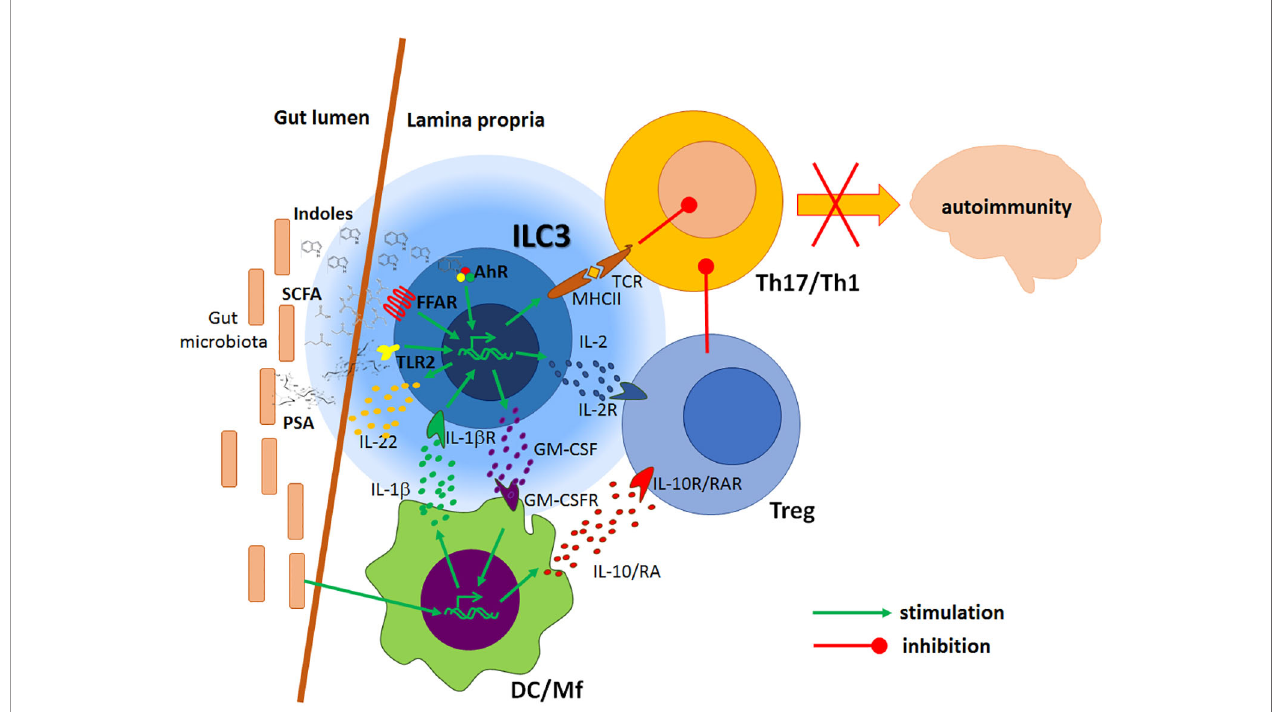
FIGURE 2 | Regulatory effects of gut ILC3 on the CNS autoimmunity. Local antigen-presenting cells (DC/Mf) produce IL-1 b under the in fl uence of gut microbiota. IL- 1 b stimulates ILC3 to produce GM-CSF, which potentiates tolerogenic properties of DC, IL-22 that stimulates intestinal barrier, and IL-2 that favours Treg. DC/Mf also produce IL-10 and retinoic acid (RA) which stimulate Treg activity. ILC3 present antigens to effector Th1 and Th17 cells, but without adequate co-stimulation, thus inhibiting their functions. Products of gut microbiota, such as polysaccharide A (PSA) and processed nutrients, such as short-chain free fatty acids (SCFA) and indoles act on ILC3 through their respective receptors to potentiate their immunomodulatory actions. Consequently, encephalitogenic Th cells are inhibited in the gut, thus ILC3 activity presumably leads to the amelioration of the CNS